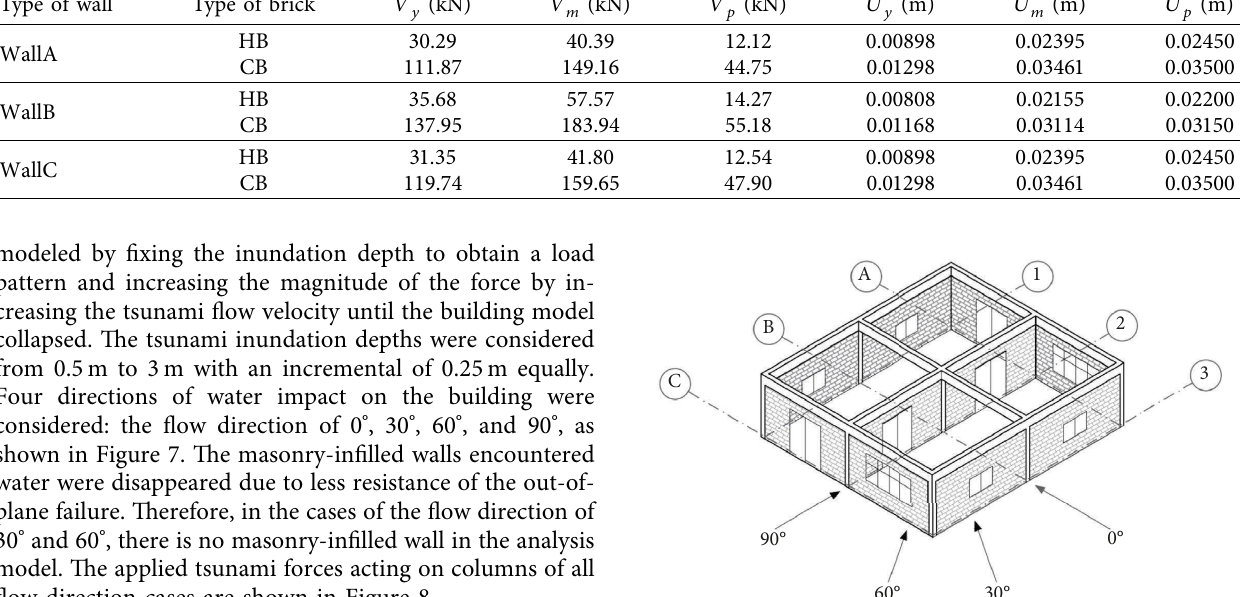
Figure 7: Tsunami fow